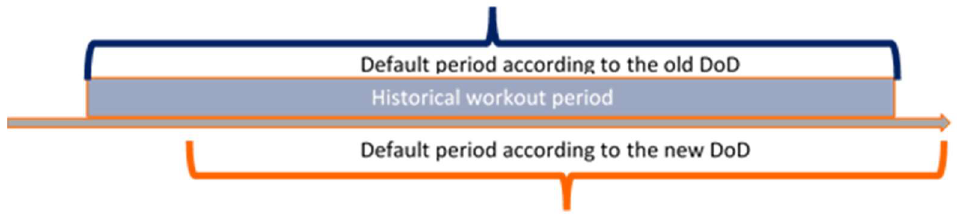
Figure 4. LGD recalibration—differences between the old and new default period. Source: own elaboration.